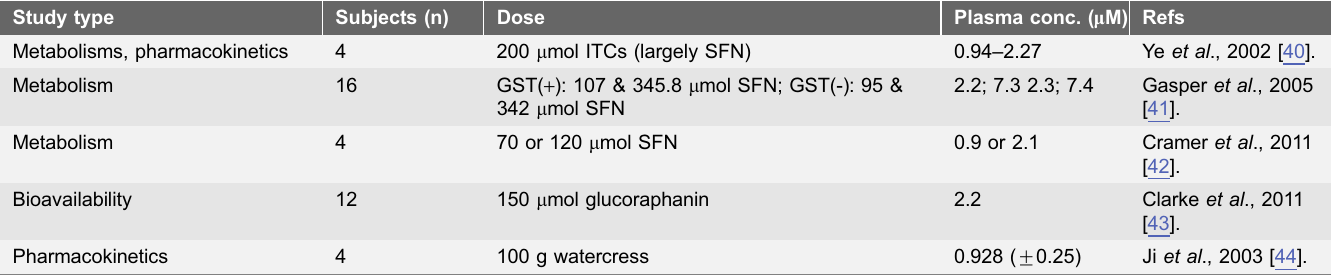
Table 1. Human studies with plasma levels of dietary